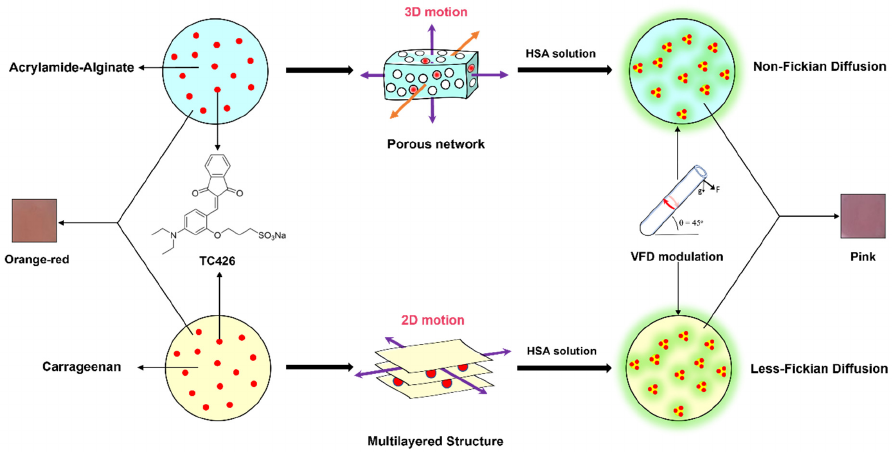
Figure 5 . Potential mechanism of TC426-embedded AAm–Alg and carrageenan hydrogel film. Figure 5. Potential mechanism of TC426-embedded AAm–Alg and carrageenan hydrogel film.